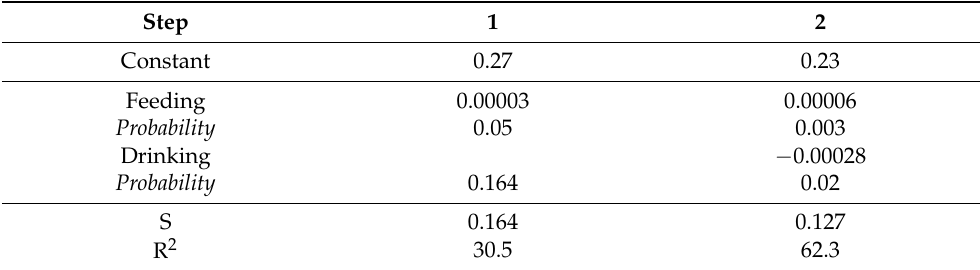
Table A3. Stepwise regression coefficients and probability values for the two steps (addition of feeding first and then drinking), when regressing mean behaviour values with mean values for the welfare issues in the